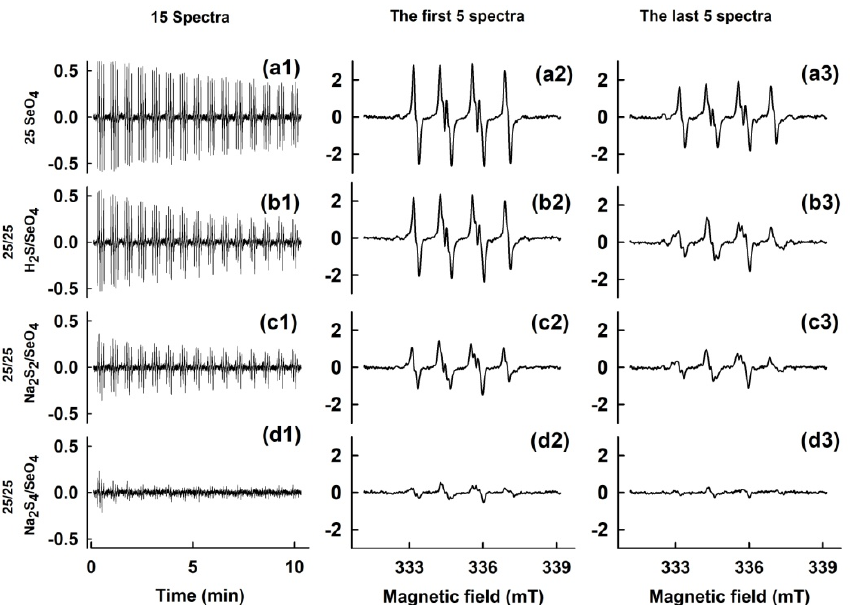
Figure 2. EPR spectra of • BMPO-OOH modulated by the mixture of Na 2 S, Na 2 S 2 and Na 2 S 4 with SeO 42 − . Representative EPR spectra from 2–3 measurements of • BMPO-OOH obtained in KO 2 /DMSO solution (final 10% v/v DMSO) in the presence of 30 mmol L − 1 BMPO prepared in buffer consisting 50 mmol L − 1 sodium phosphate buffer and 0.1 mmol L − 1 DTPA (pH 7.4, 37 °C), after the addition of